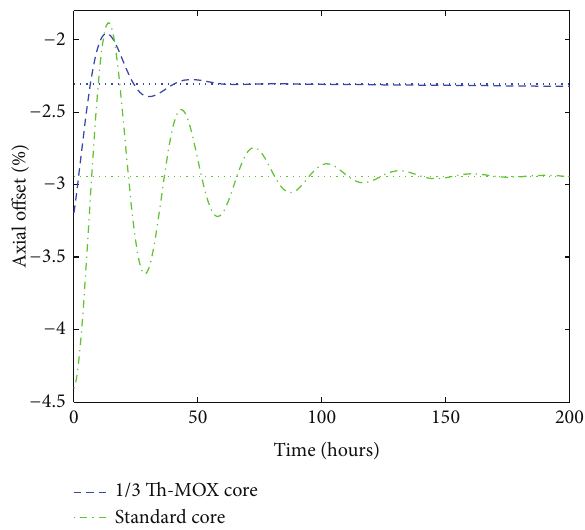
Figure 9: The AO oscillation as function of time in the standard and 1/3 Th-MOX core.